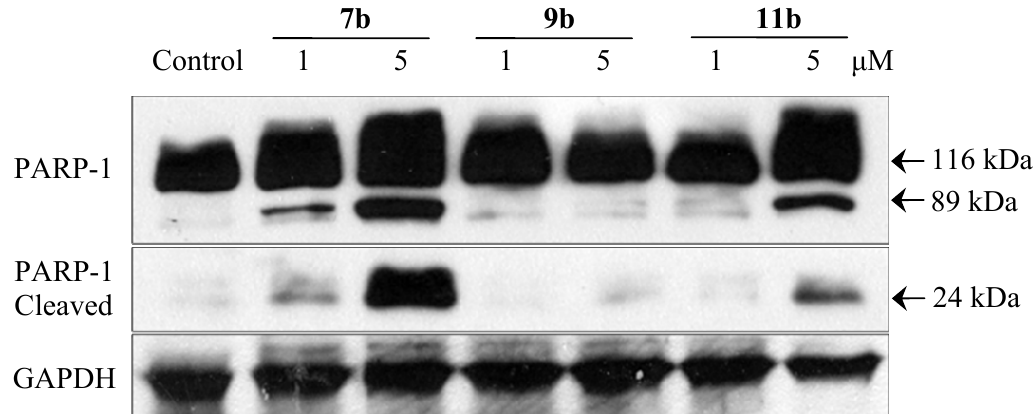
Figure 6. Effect of compounds on PARP-1 cleavage in HCT-116